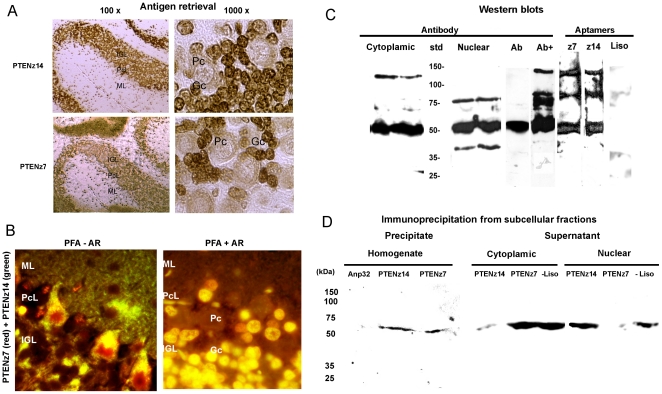
Antigen retrieval and PTEN detection in cerebellar subcellular fractions.
A. No crosslinking fixation. Histologic samples showing the peroxidase staining pattern of denatured proteins. 100× and 1000× magnifications are indicated at the top of each column. The denaturation was achieved through heating of the tissue, a technique commonly known as antigen retrieval (AR). The aptamer utilized for the staining is indicated on the left of each row. The cerebellar cortex layers are indicated in each micrograph as: molecular layer (ML); Purkinje cell layer (PcL); internal granular layer (IGL). The micrograph at 1000× magnification indicates Purkinje cells (Pc) and granule cells (Gc). B. Crosslinking fixation. Histologic samples fixed with paraformaldehyde (PFA) with and without antigen retrieval (+AR and -AR respectively) were stained simultaneously with PTENz7 (CY3-red) and PTENz14 (FITC-green). Colocalization was observed as yellow labeling at 400× magnification. C. Western blot subcellular fractions and homogenates. Homogenates and subcellular fractions were developed using a polyclonal antibody against the carboxy terminus of PTEN. Cytoplasmic fraction presented a large amount of PTEN, corresponding to the 55-kDa band. Another band of 120 kDa was also observed in this fraction (duplicates). The nuclear fraction presented a major band of 55 kDa with two minor bands of 80 kDa and 40 kDa. In homogenates, the major band of 55 kDa was observed (Ab), but required overexposure (Ab+) to detect the modified-mobility isoforms. The band of 55 kDa had a lower intensity than the antibody band. Both aptamers PTENz7 (z7) and PTENz14 (z14) detected the 80-kDa and 120-kDa bands. Controls were put in place using the negative chain corresponding to the lysozyme aptamer (Liso). D. Immunoprecipitation assays. Proteins from cerebellum homogenate were utilized to purify PTEN by means of the aptamers PTENz7 and PTENz14. The aptamer Anp32 was used as a negative control for the purification. The purified proteins were separated in denaturing 10% SDS-PAGE, transferred to a nitrocellulose membrane and detected using goat antibodies against GST-PTEN protein. Corresponding aptamers are indicated above each western blot lane, while the molecular weight is denoted to the left of the image. The PTEN protein was precipitated from the subcellular fractions and the presence of the protein was analyzed in the supernatants. Note that PTENz7 was able to diminish the PTEN staining from the nuclear fraction, whereas PTENz14 affects the cytoplasmic fraction.